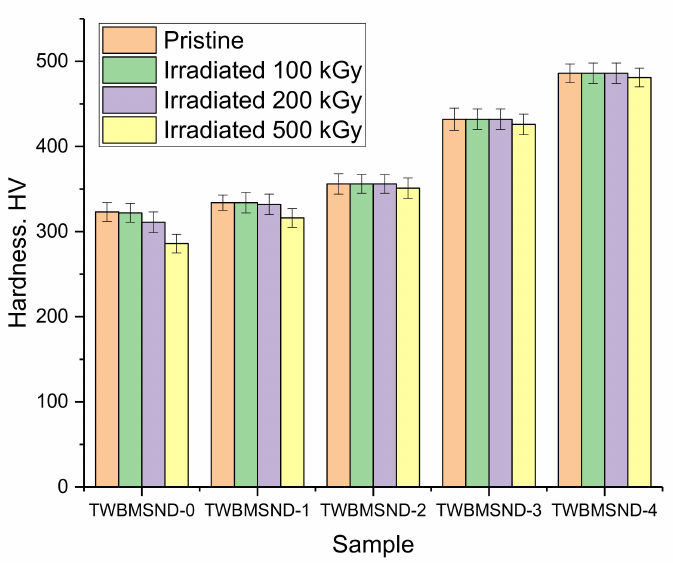
Figure 7. Results of changes in the hardness of samples depending on the irradiation